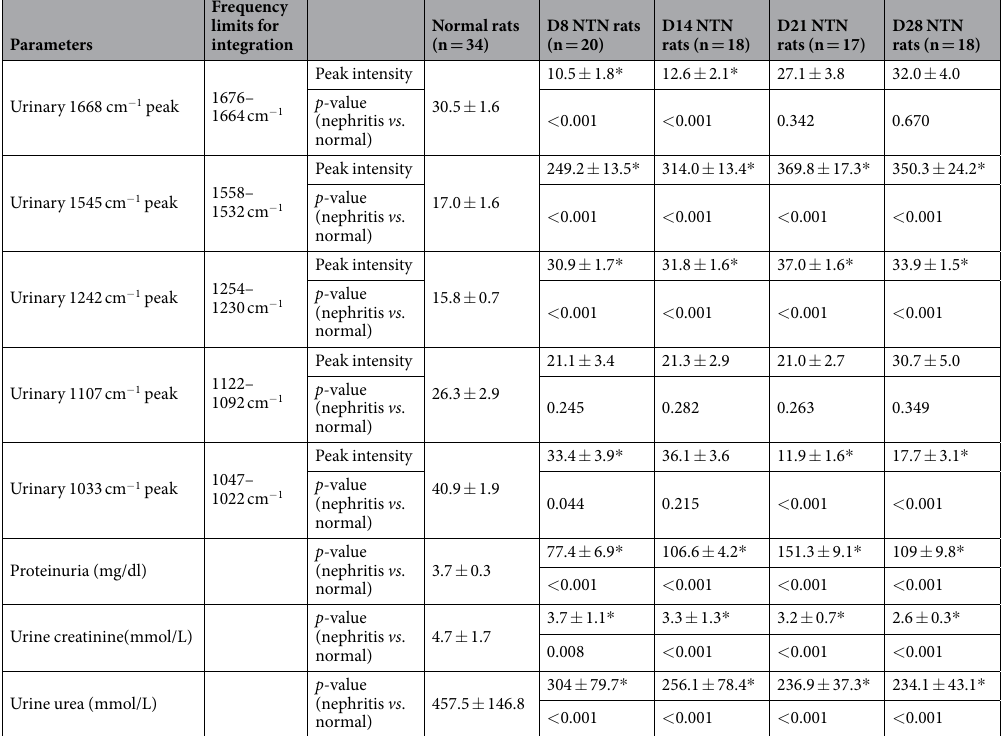
6 Scientific RepoRts | 7: 4601 | DOI:10.1038/s41598-017-04774-7